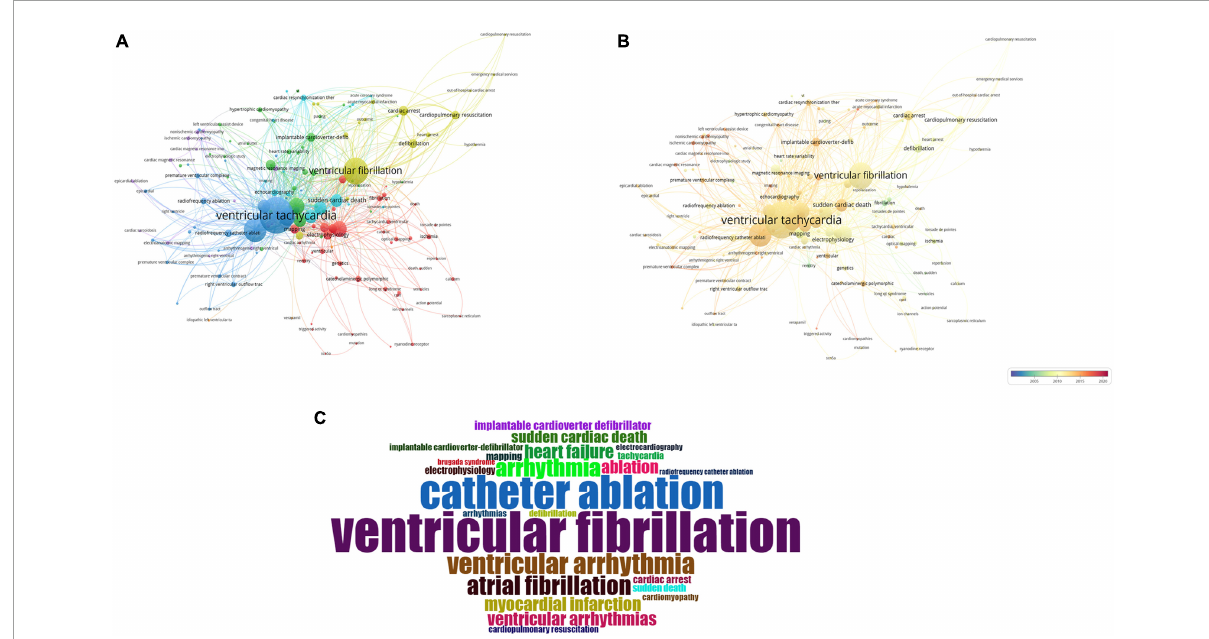
clearly illustrating the higher degrees of citation bursts in cluster labels at different time points (e.g., #0, #1, #3, and